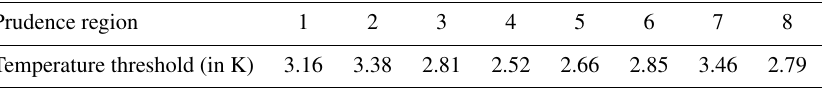
Table 1. Ensemble mean variation of the temperature threshold calculated for heat periods with the standard approach in CCLM data (see Sect.